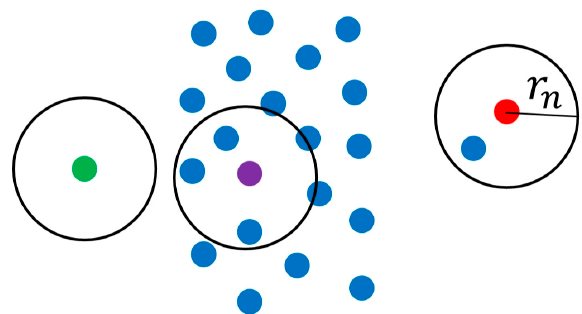
Figure 6. The point cloud filtering method based on the neighborhood radius.